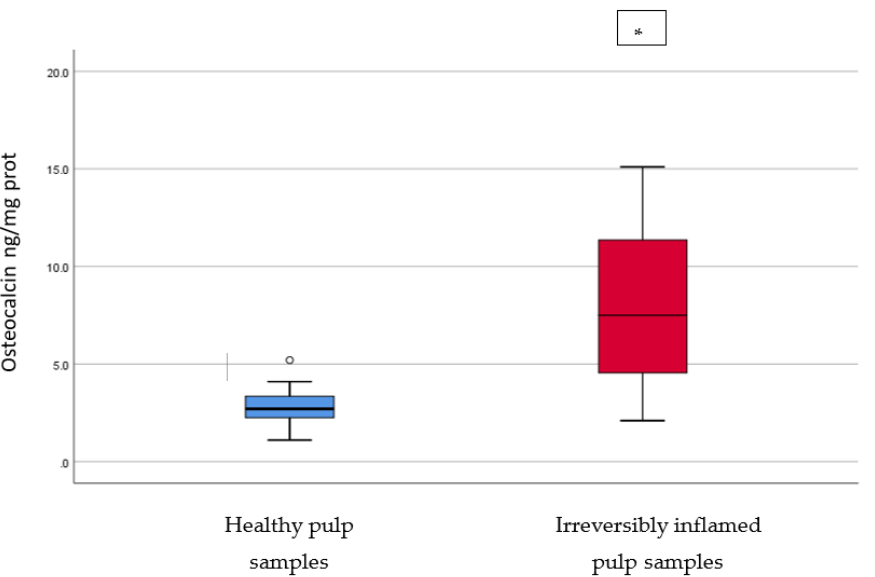
Figure 5. Comparison of Osteocalcin levels (ng/mg protein) in healthy and irreversibly inflamed dental pulp samples, respectively. The distribution of variables is parametric in both groups according to the Shapiro – Wilk test ( p > 0.05). Welch’s t -test shows that the differences between the two groups are statistically significant ( p < 0.001). (* indicates a statistically significant difference).